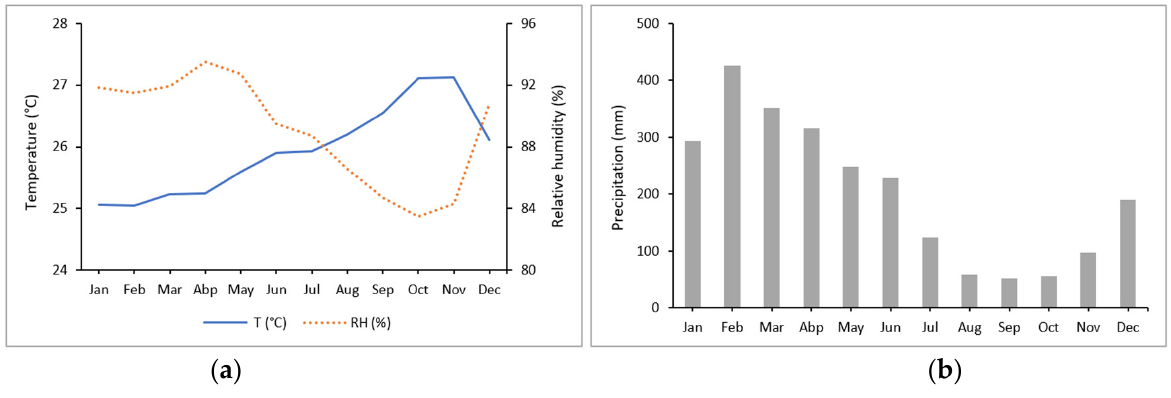
Figure 2. ( a ) Average monthly temperature and relative humidity and ( b ) average total monthly precipitation from September 2017 to November 2019. precipitation from September 2017 to November